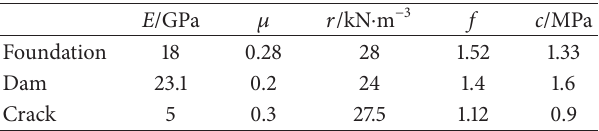
Figure 14: Distribution of dam body unbalanced force under over- load 2.0𝑃 0 in scheme 2.